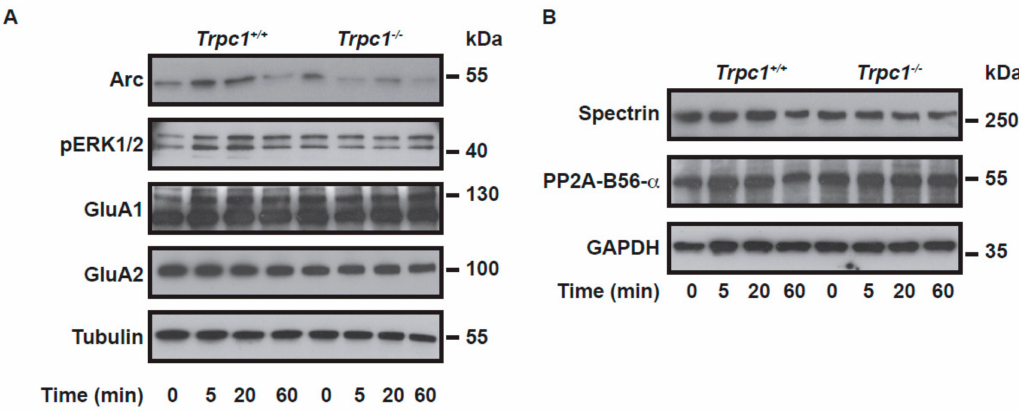
Figure 5. DHPG-induced signaling pathways. Western Blot analysis of protein expression in hippocampal slices stimulated for 0, 5, 20, or 60 min with 50 µ M DHPG (two slices per sample, n = 3 to five independent experiments per group) A . The phosphorylation of ERK1 / 2 and the expression of Arc were significantly increased (by 3.6 times and 1.6 times, respectively) after a 5 and 20 min stimulation with DHPG in the Trpc1 +/+ brain slice. B . The expression of B56 α and spectrin were significantly diminished (by 20 and 22% respectively) after a 60 min stimulation with DHPG in Trpc1 +/+ brain slices. These e ff ects were not observed in Trpc1 − / −